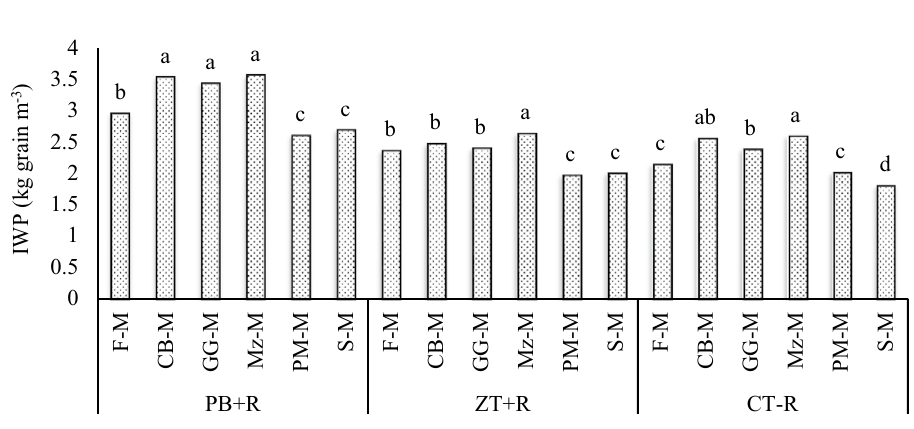
Figure 6. Irrigation water productivity of CA-based Indian mustard systems (3-year